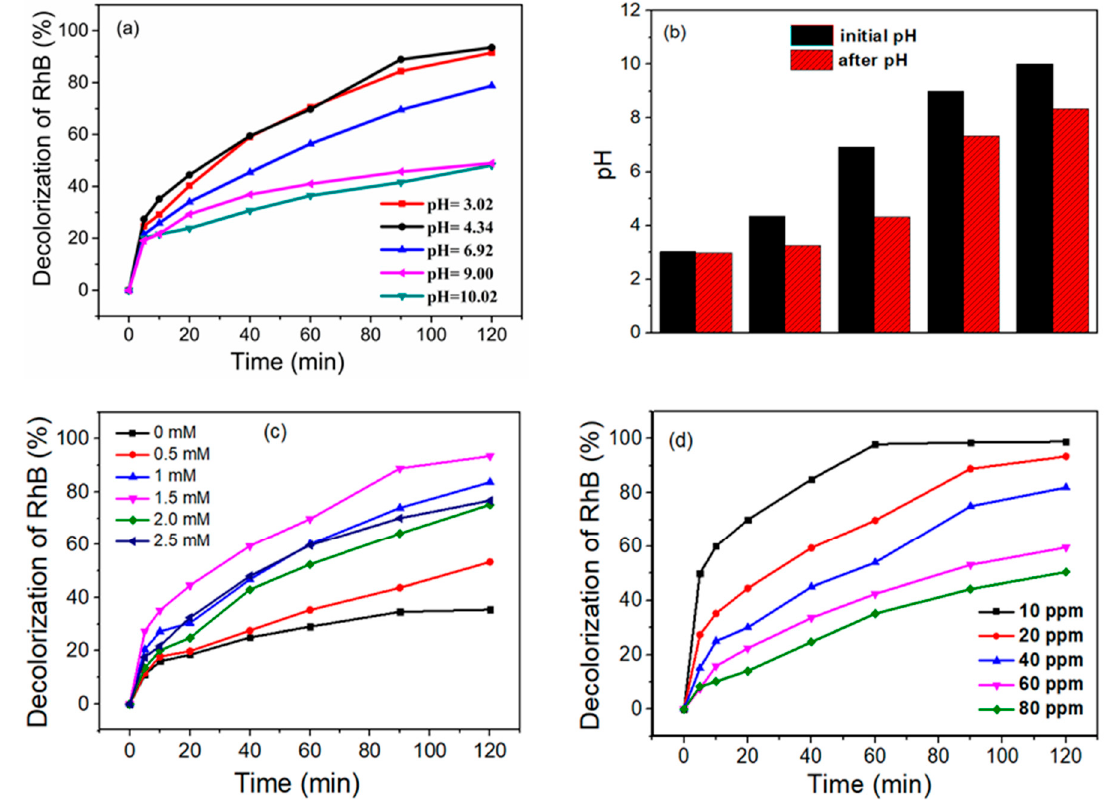
Figure 3. ( a ) Effect of initial pH (reaction conditions: 200 mg catalyst + 20 ppm RhB + 1.5 mM persulfate (PS)), ( b ) initial and after pH, ( c ) the influence of persulfate dosage (reaction conditions: 200 mg catalyst + 20 ppm RhB + 4.34 pH), and ( d ) the influence of RhB concentrations (reaction conditions: 200 mg catalyst + 1.5 mM PS + 4.34 pH).